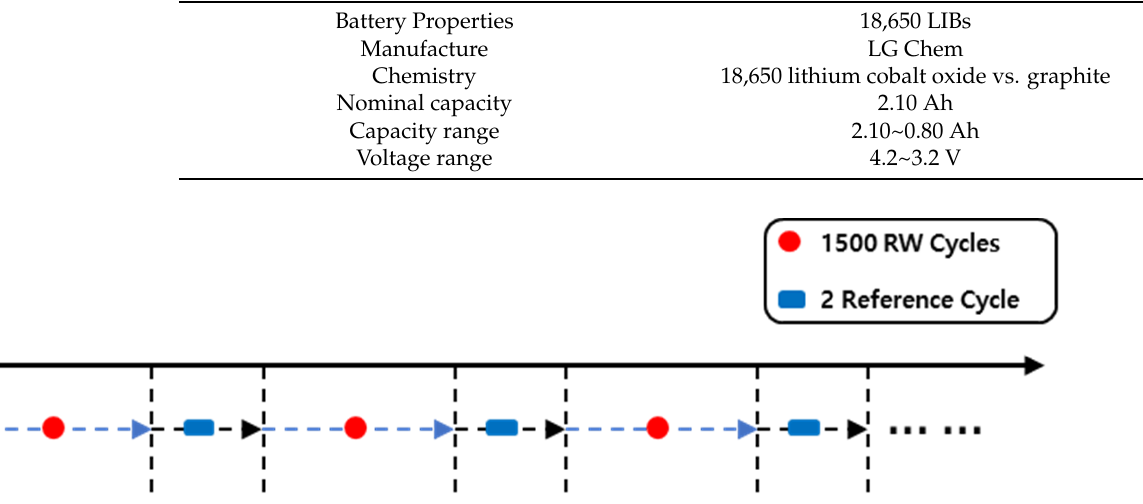
( b ) Figure 2. The RW steps measured for battery RW9: ( a ) first 50 RW steps; ( b ) last 50 RW steps. ( a ) ( b ) Figure 3. The reference discharge profile of RW9: ( a ) voltage; ( b ) temperature. 3. SOH Estimation Methods 3.1. Preprocessing Methods 3.1.1. Continuous Wavelet Transform (CWT) Unlike the Fourier transform, which has a fixed resolution and cannot represent the characteristics of non-periodic signals well, wavelet transform methods have the ad- vantage that signals can be analyzed efficiently using a wavelet function that has flexible resolution [31]. A time-series analysis using the wavelet transform utilizes 𝜓(𝑡) , the mother wavelet, which is defined in Equation (1).